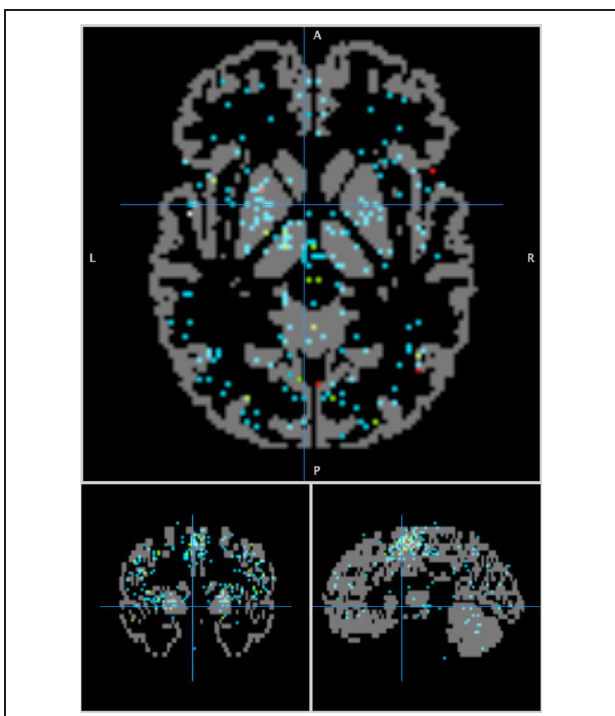
FIGURE 3 | The ‘Action:Execution’ behavior sub-domain image. Activation foci are overlaid onto gray matter from the Talairach Daemon (Lancaster et al., 2000) to provide an anatomical background. Crosshair at ( − 4, 0,